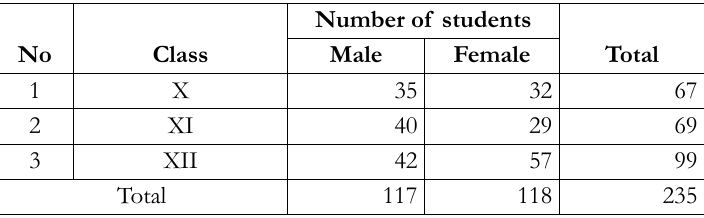
Table 3. Number of students in the academic year of